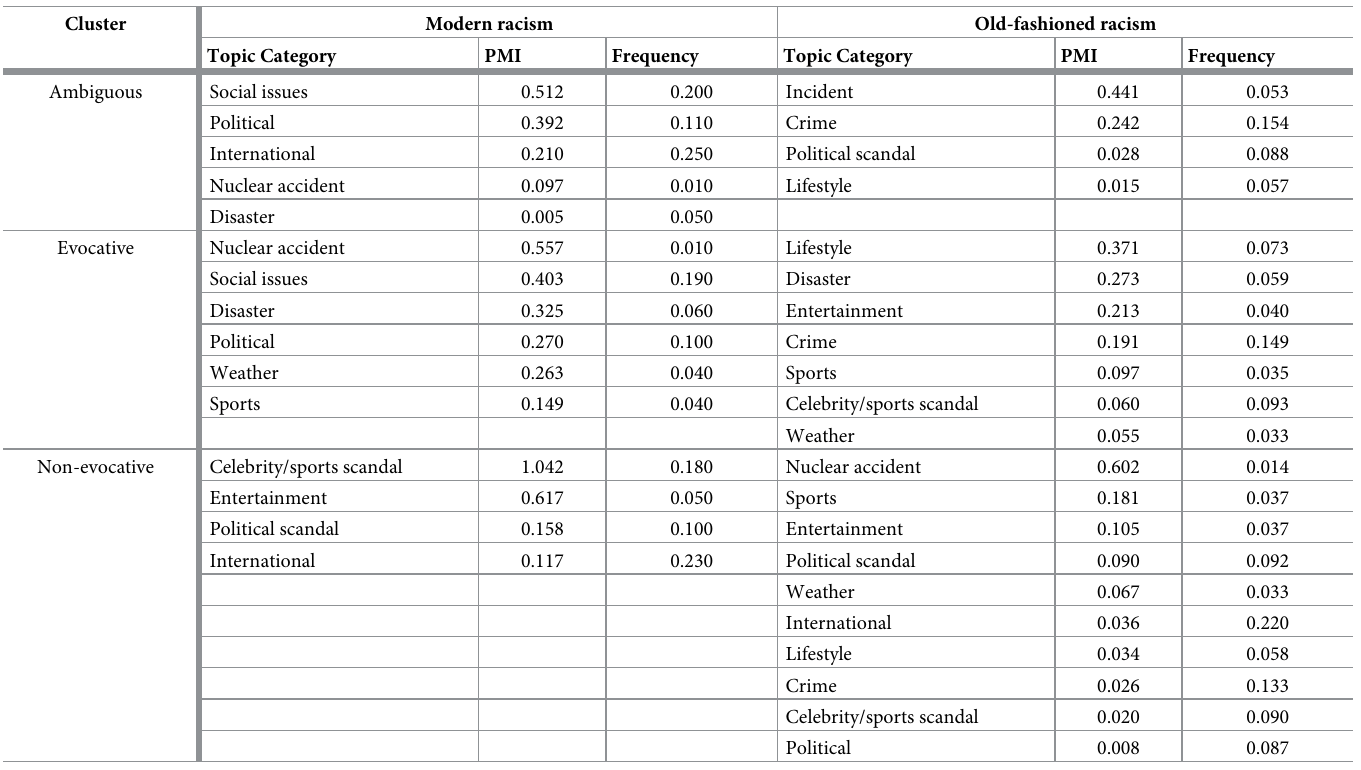
because we classified the news grids related to South Korea and North Korea as international news. This news was not about Zainichi Koreans (i.e., Korean residents in Japan), but the expression of modern racism, which is about Zainichi Koreans in specific, was